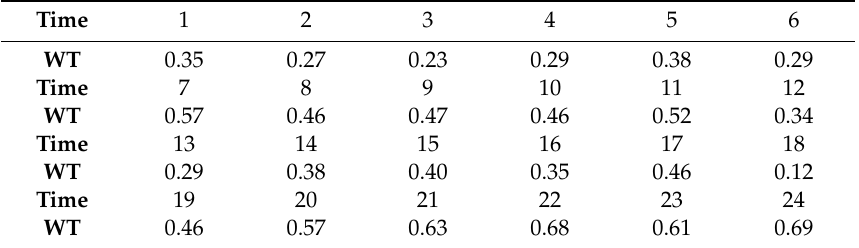
Table 2. Generation of non-dispatchable units (MW) / installed (MW). WT: wind